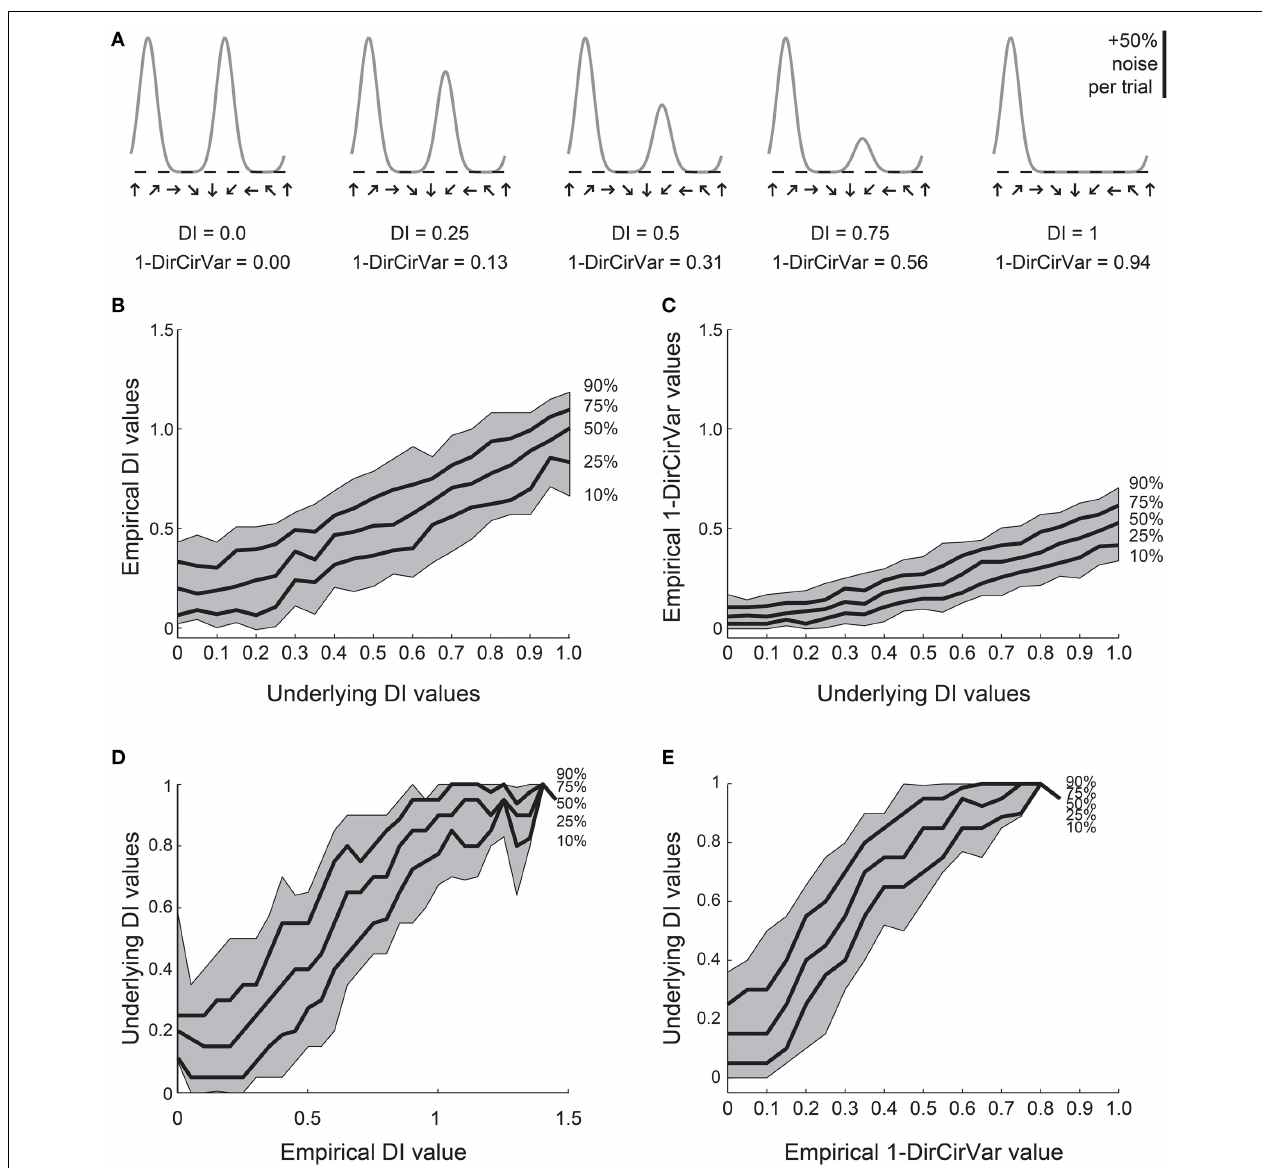
FIGURE 5 | Comparison of DI and direction circular variance measures for simulated data. We created 100 simulations of tuning curves for each of 21 underlying “true” tuning curves, ranging from DI = 0 to DI = 1, some curves shown in (A) . Each trial had 50% noise added. (B) Percentiles of the empirically determined DI for the 100 simulations at each underlying “true” DI value. Note that for cells with 0 true selectivity, the empirical DI values range from about 0 to about 0.5. (C) Percentiles of the empirically determined 1- DirCirVar index for each of the underlying “true” DI values. Note that when “true” DI is low, the 1- DirCirVar is always low. The index 1- DirCirVar increases as “true” OI increases but the range of values remains